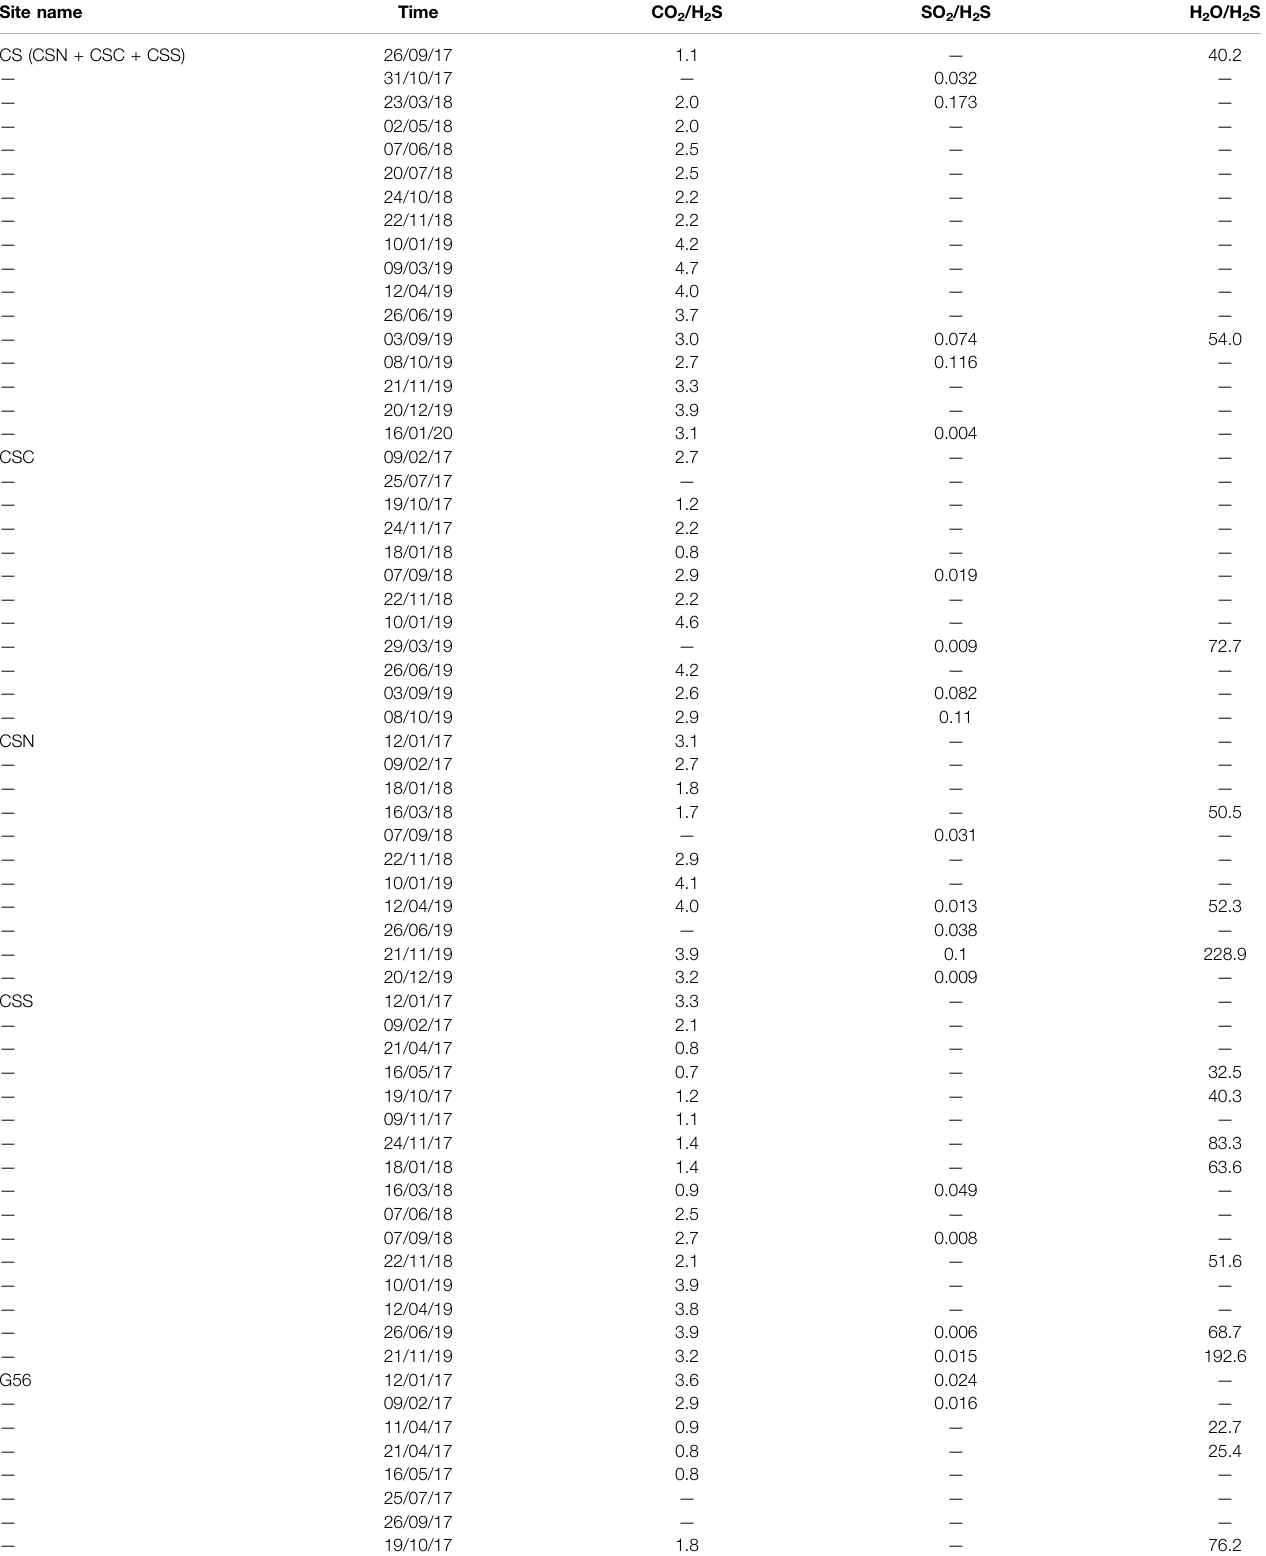
TABLE 1 | Molar gas ratios in fumarolic emissions from La Soufrière volcano measured with portable MultiGas in 2017 – 2020. Site